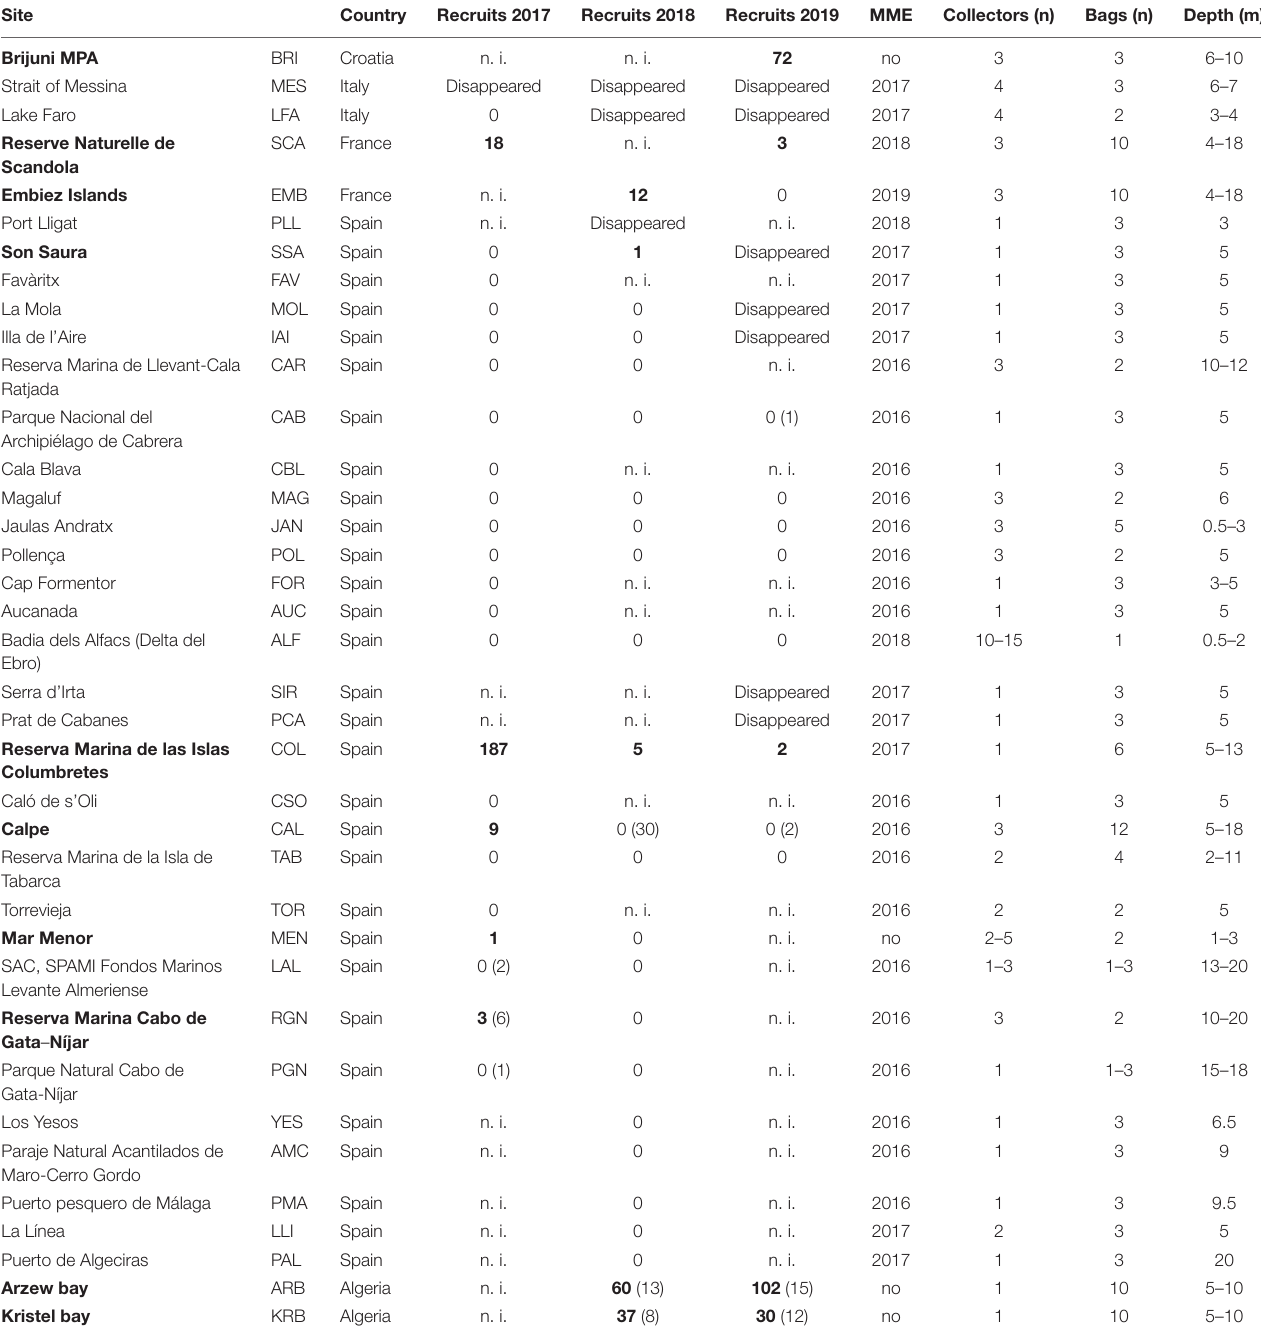
TABLE 1 | Larval collector sites, 2017–2019 recruitment data and year of affection by the MME.